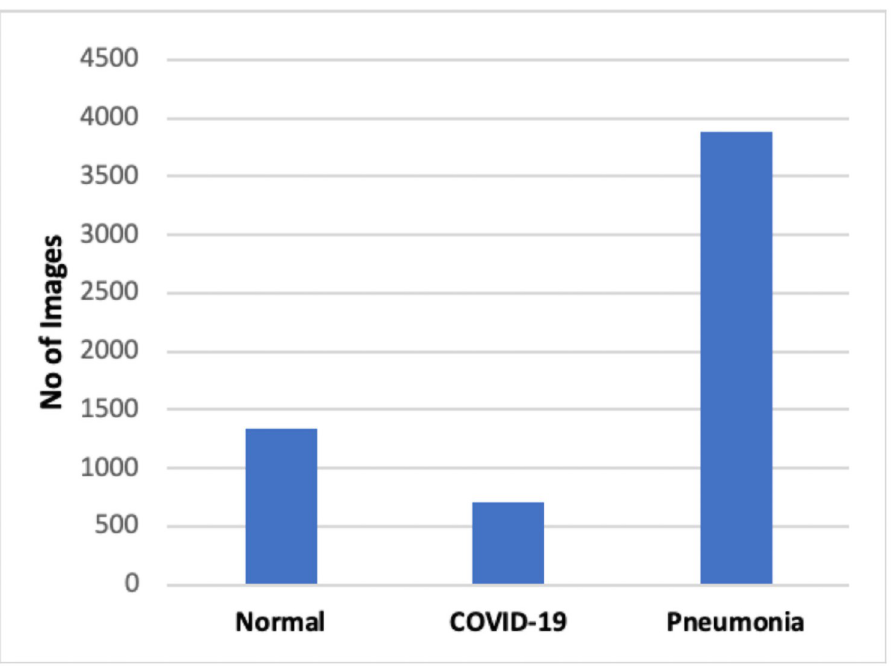
Fig 3. Variation in chest x-ray images distribution.